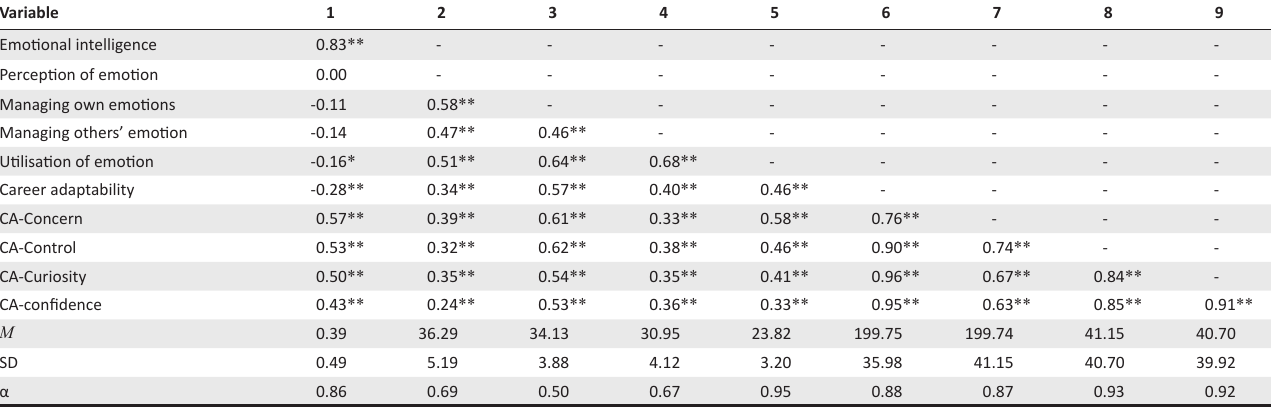
TABLE 1: Bivariate correlations, mean and standard deviations between all variables ( N = 160).